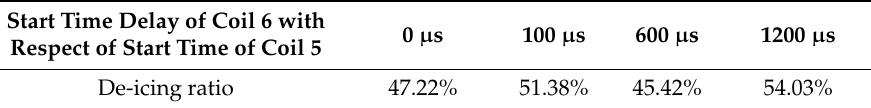
Table 7. De-icing Table 7. De-icing ratios.